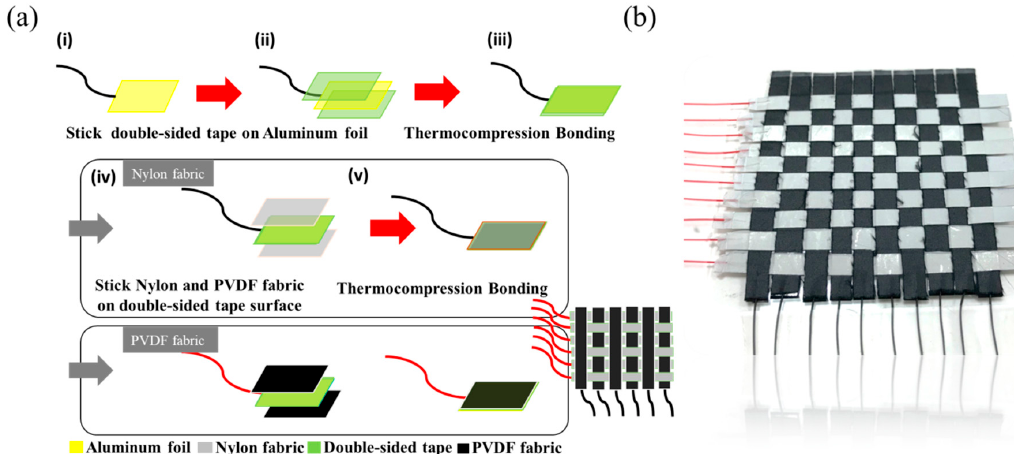
Figure 2. ( a ) Schematic illustration of the systematic protocol to fabricate the Woven Triboelectric Nanogenerator (WTENG) . ( b ) An image of the 10 × 10 WTENG.